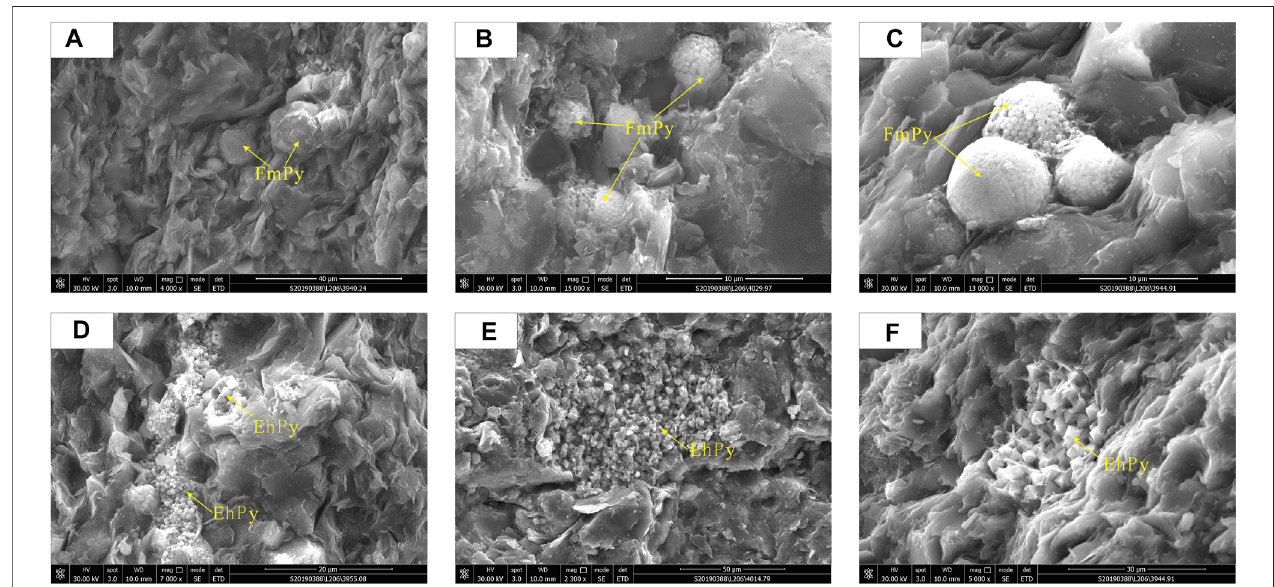
FIGURE8| Microphotographsshowingdifferenttypesofpyrites. (A) Framboidalpyrite(FmPy)associatedwithillite,3940.24 m,L206; (B) framboidalpyrite(FmPy), 4029.97 m,L206; (C) framboidalpyrite(FmPy),3944.96 m,L206; (D) lamellareuhedralpyriteaggregate(EhPy),3955.08 m,L206; (E) euhedralpyriteaggregate(EhPy), 4014.79 m, L206; and (F) euhedral pyrite (EhPy), 3944.96 m,